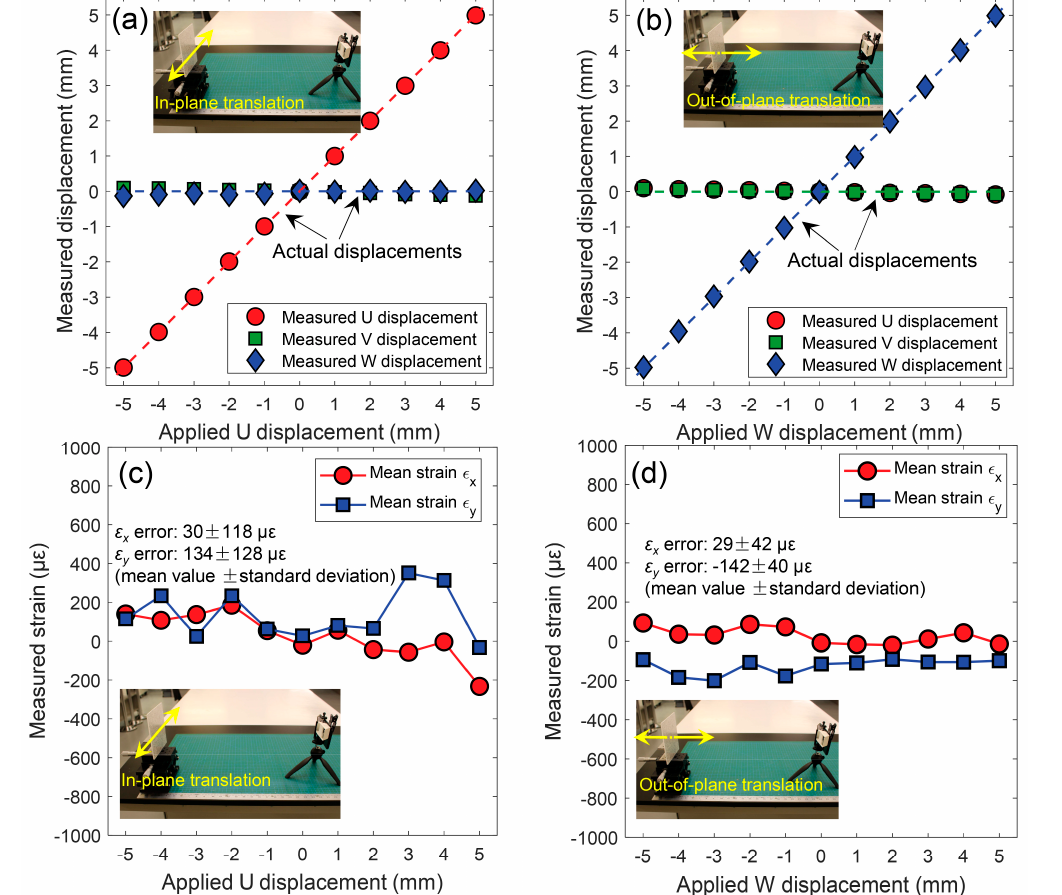
Figure 5. Measured U , V and W displacements (unit: mm) as a function of the applied displacements for ( a ) in-plane translation tests along the X direction and ( b ) out-of-plane translation tests along the Z direction. Measured horizontal and vertical strains (unit: με ) as a function of the applied displacements for ( c ) in-plane translation tests along the X direction and ( d ) out-of-plane translation tests along the Z direction.